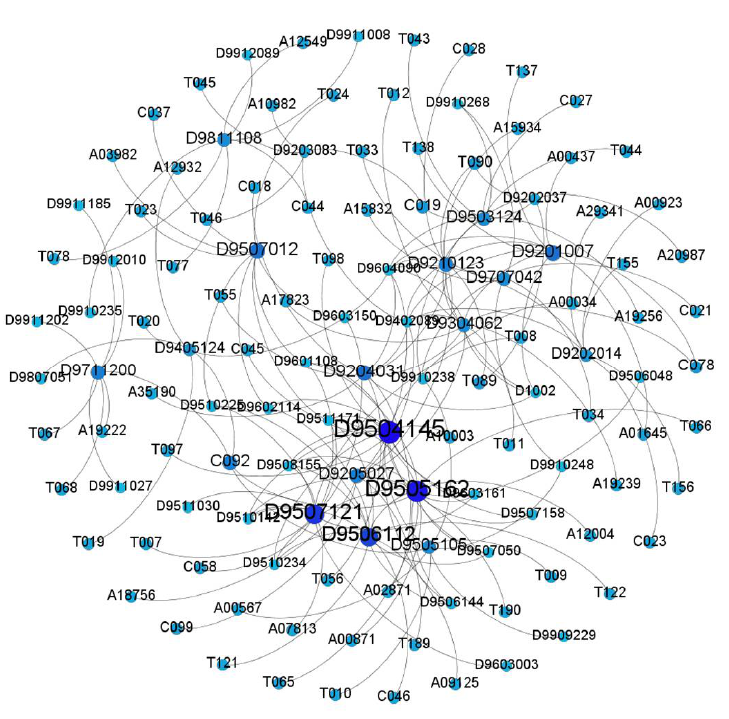
Figure 5. Sampling example of the heterogeneous academic network (visualized by the software Gephi).